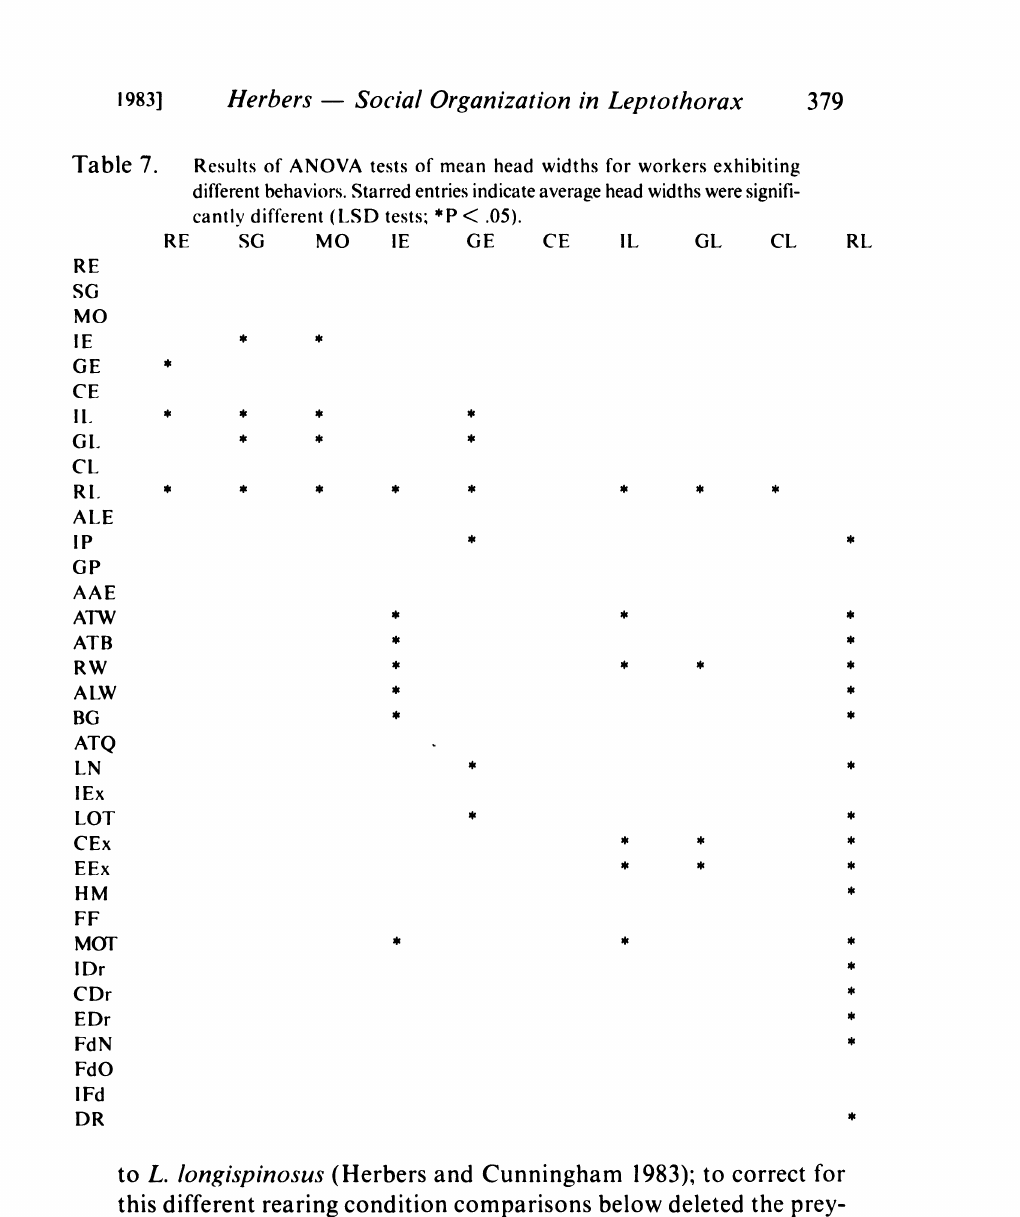
Results of ANOVA tests of mean head widths for workers exhibiting different behaviors. Starred entries indicate average head widths were signifi- cantly different (LSD tests; *P < .05). RE